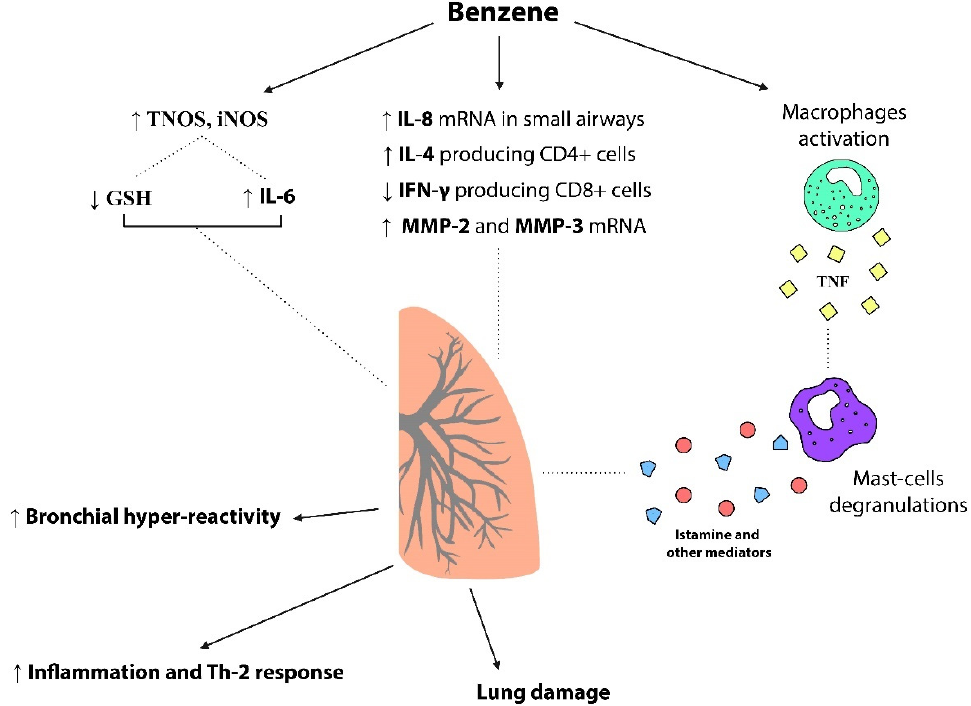
Figure 3. Respiratory-related hypersensitivity effects and immunological actors in benzene expo- sure.